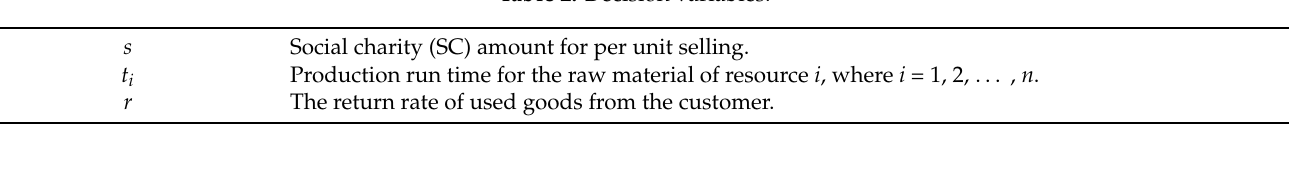
Table 2. Decision